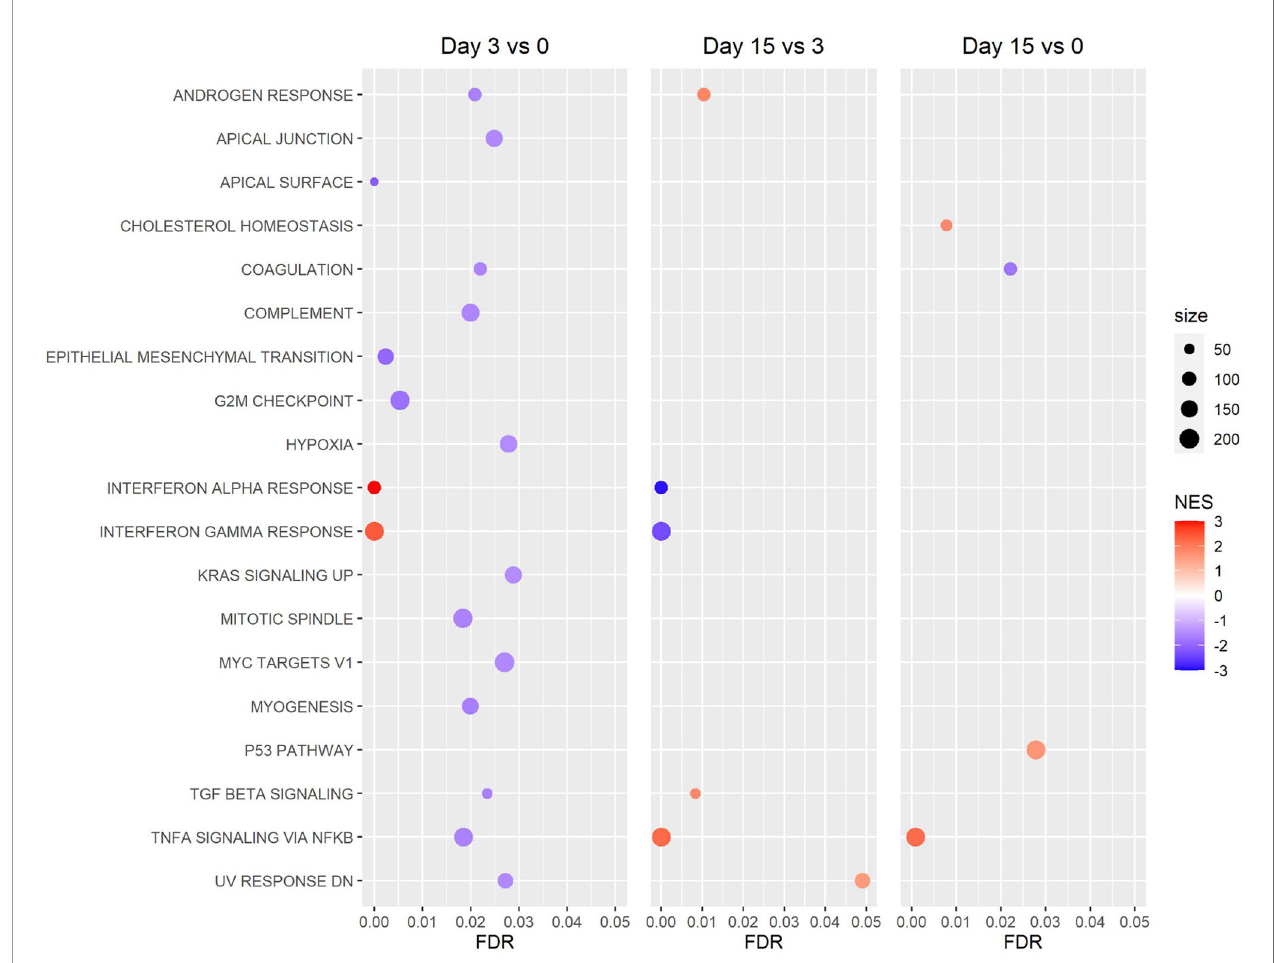
FIGURE 7 | Gene Set Enrichment Analysis (GSEA) of Hallmark gene sets. Revealed a pattern of increased expression of genes associated with the interferon alpha and gamma response between the beginning and peak of infection (day 3 vs 0), then decreased expression of these genes between the peak and resolution of infection (day 15 vs 3). (NES: Normalized Enrichment